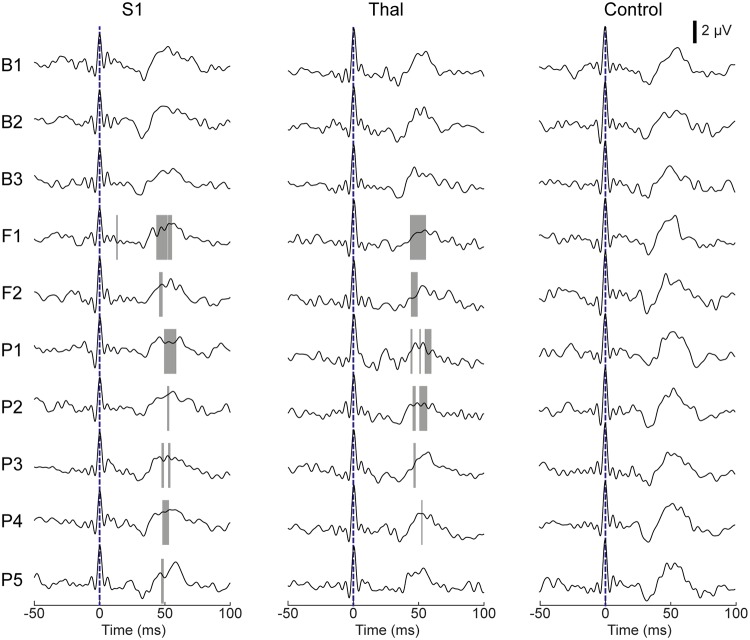
Group-averaged SEP (acquired from the use of SP1 and SP3 parameter conditions) across data acquisition segments for the sonication targets (S1, thalamus).The time-locked averaged SEPs are shown before (B1–B3), during (F1, F2), and after (P1–P5) sonication of the S1 (left column, n = 17 across 9 sheep) and thalamus (middle column, n = 16 across 8 sheep). The SEPs acquired from the control condition (i.e., sonication of the ipsilateral S1/thalamic targets, right column, n = 17 across 5 sheep) are also shown. Gray bars in the plot indicate the time intervals that showed significant differences in amplitude compared to the control condition (one-tailed t-test, p < 0.01).